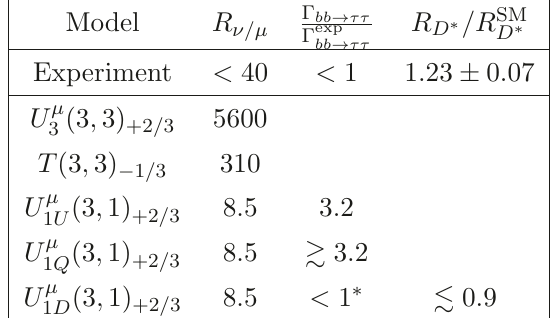
Table 2 . MFV-predictions of simplified leptoquark models that account for the R R is discussed in section 3.2, Γ bb → ττ in section 4.2, and R ν/µ means that consistency with the observable applies for a small range of the parameter x